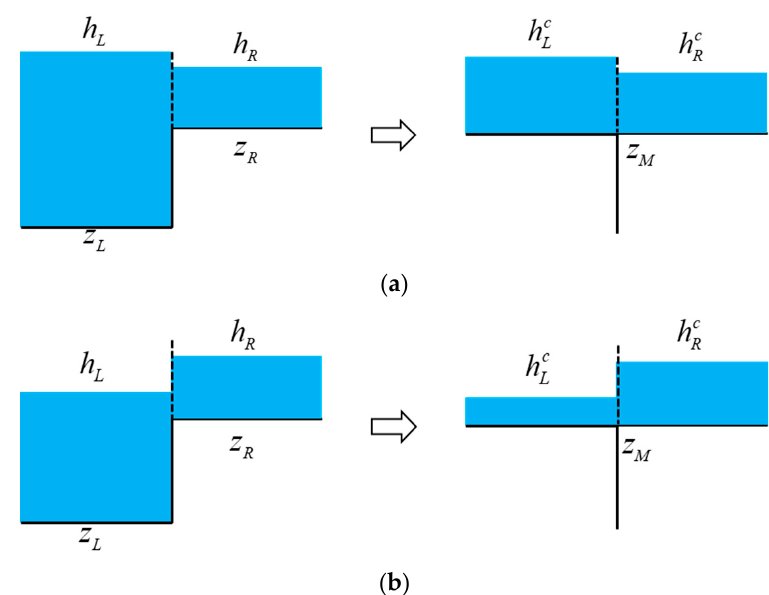
( c ) Figure 2. Illustration of hydrostatic reconstruction at: ( a ) h L + z L > h R + z R ; ( b ) h L + z L < h R + z R ; and ( c ) h L + z L < z R. 3.3. Interface Numerical Flux and Slope Source Term Discretization The SWEs are solved using a Godunov-type fi nite volume scheme in this model. The interfaces fl ux is calculated by solve Riemann problem. However, it is di ffi cult to calculate the analytical solution to the Riemann problem quickly due to the large amount of com- putation cost. In the current work, the HLLC approximate Riemann solver [17] is used to calculate the numerical fl ux at the interface. The Riemann problem only requires solving once at each edge to detect the numerical fl ux at the cell interface using Equation (7) − (10). The interface fl ux is calculated using the reconstructed variables in Section 3.2, and the fl ux is given by the HLLC approximate Riemann solver as: *